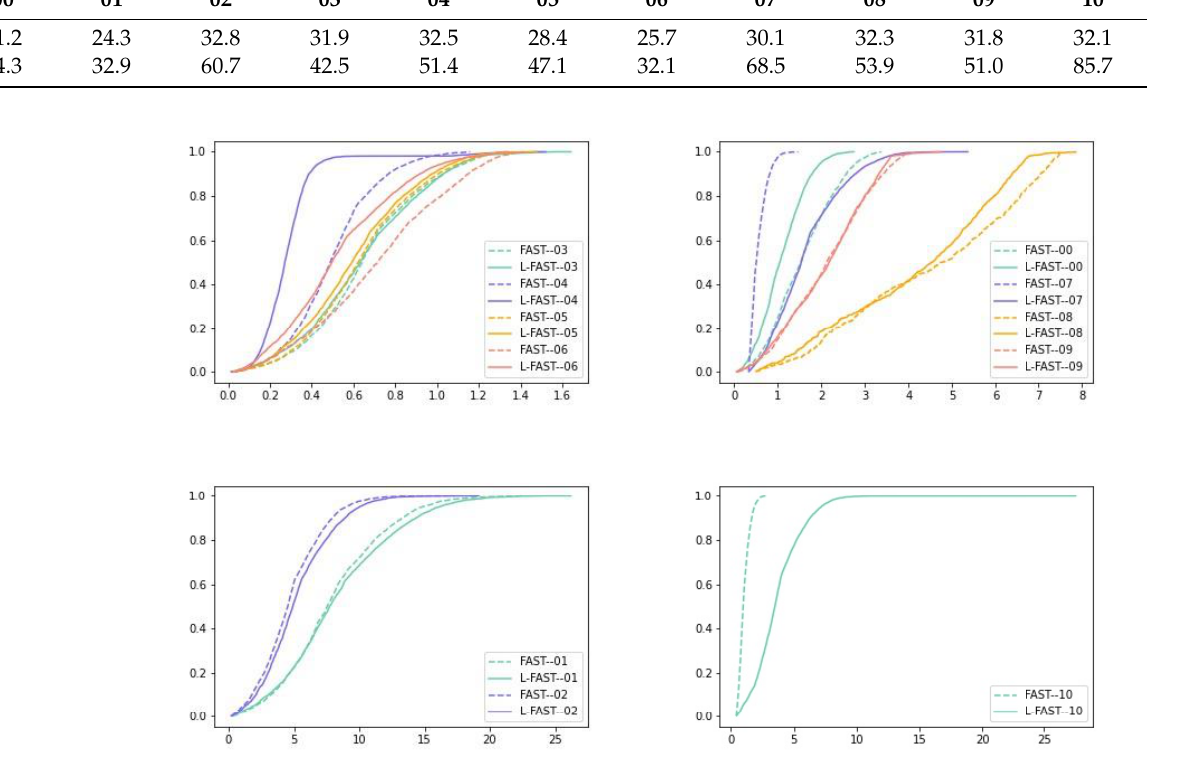
Table 3. The analysis of absolute trajectory errors.